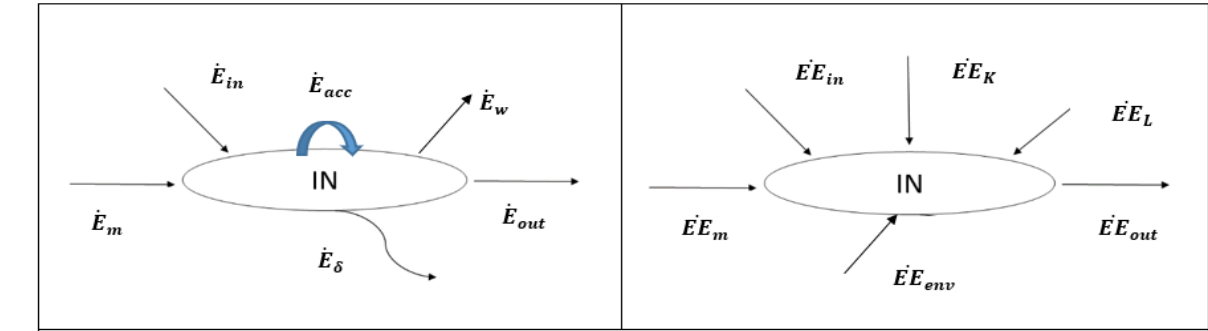
Figure 11. Black box model of the industrial sector within the context of an exergy analysis ( left ) and extended exergy analysis ( right ).